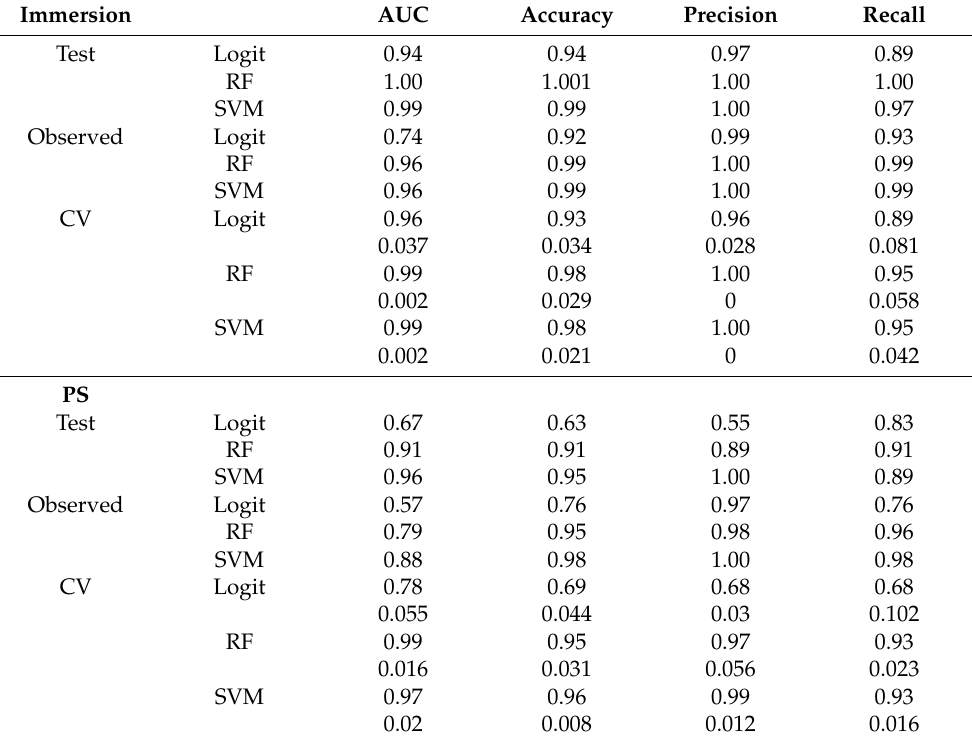
Table A10. ML classification of Mood using Immersion and PS with a 2-day lag in regularized logit, random forest (RF), and support vector machine (SVM) estimations. CV is cross-validation.